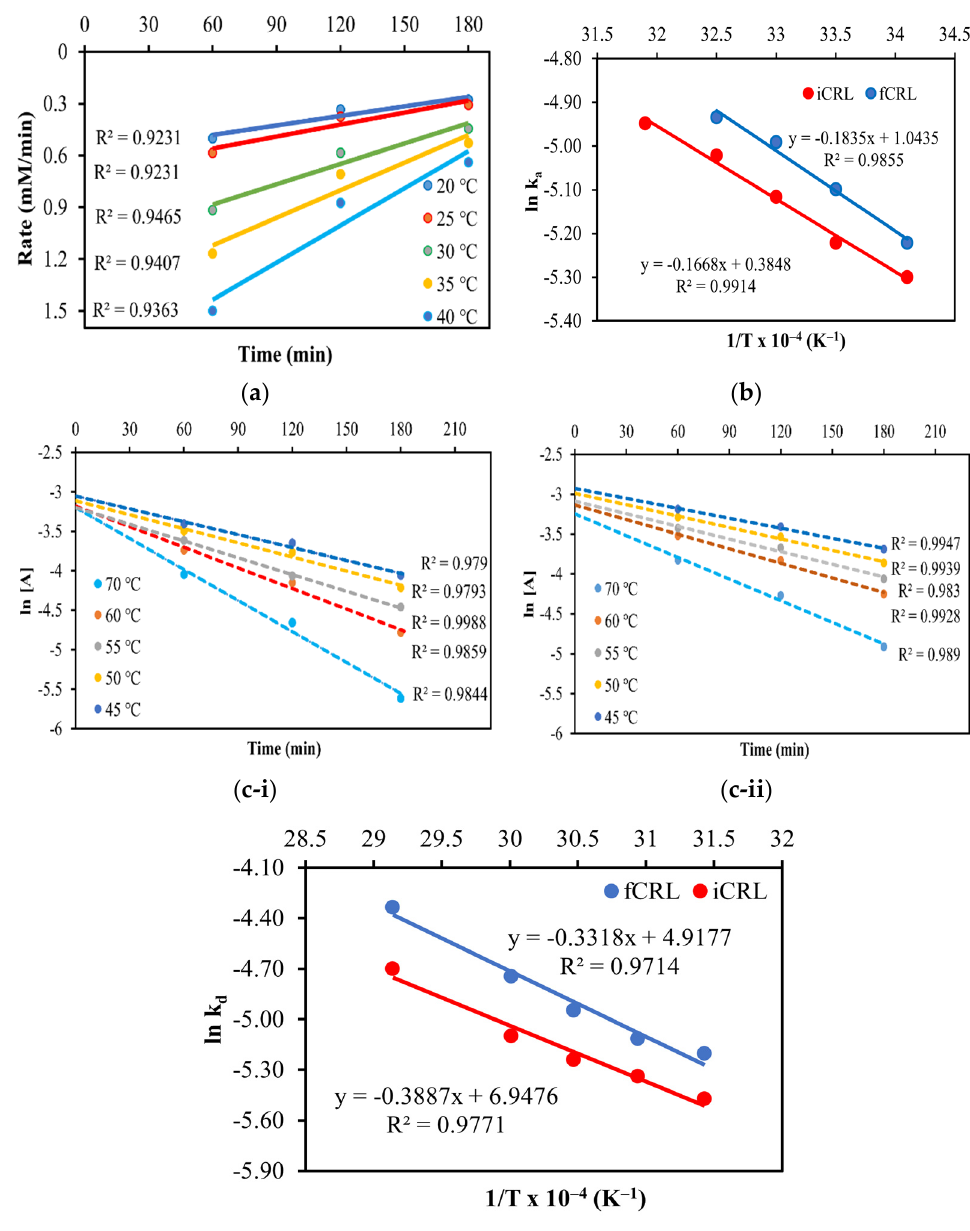
Figure 7. ( a ) First-order plot for the thermal activation rate constants ( k a ) at various temperatures, ( b ) Arrhenius plot for the activation energy for free CRL (fCRL, blue), and CRL/SiO 2 /Fe 3 O 4 /GO (iCRL, red), ( c-i , c-ii ) First-order plots for thermal deactivation rate constants ( k d ) , and ( d ) Arrhe- nius plot for the deactivation energy of free CRL (fCRL, blue), and CRL/SiO 2 /Fe 3 O 4 /GO (iCRL, red), respectively. Table 1. Summary of activation and deactivation energies of free CRL and CRLSiO 2 /Fe 3 O 4 /GO.